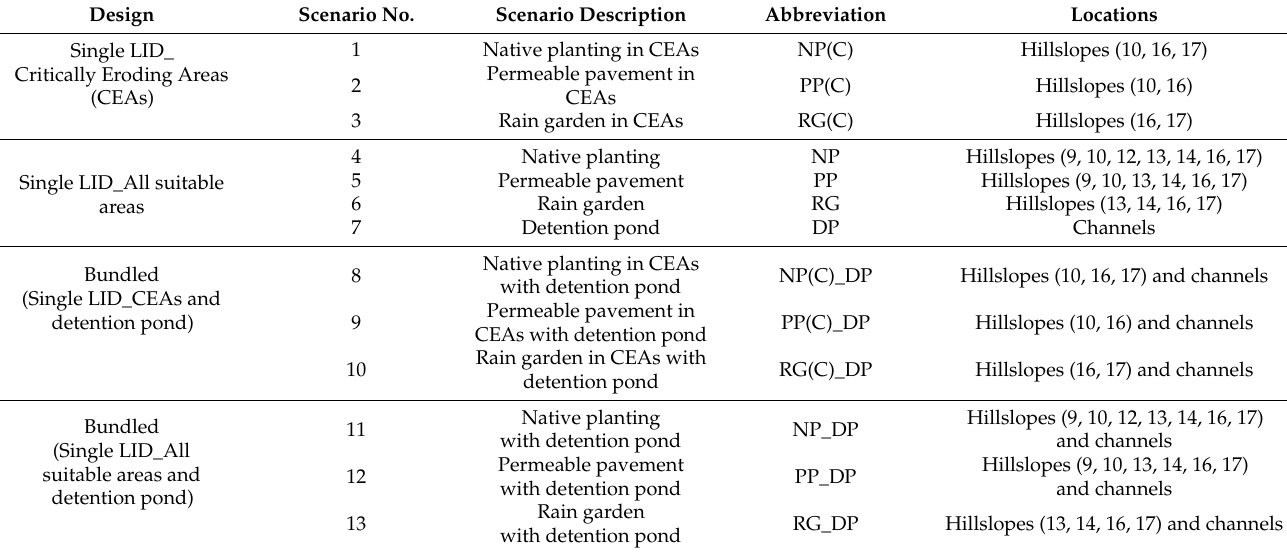
Table 1. Urban Low Impact Development (LID) design and locations in the